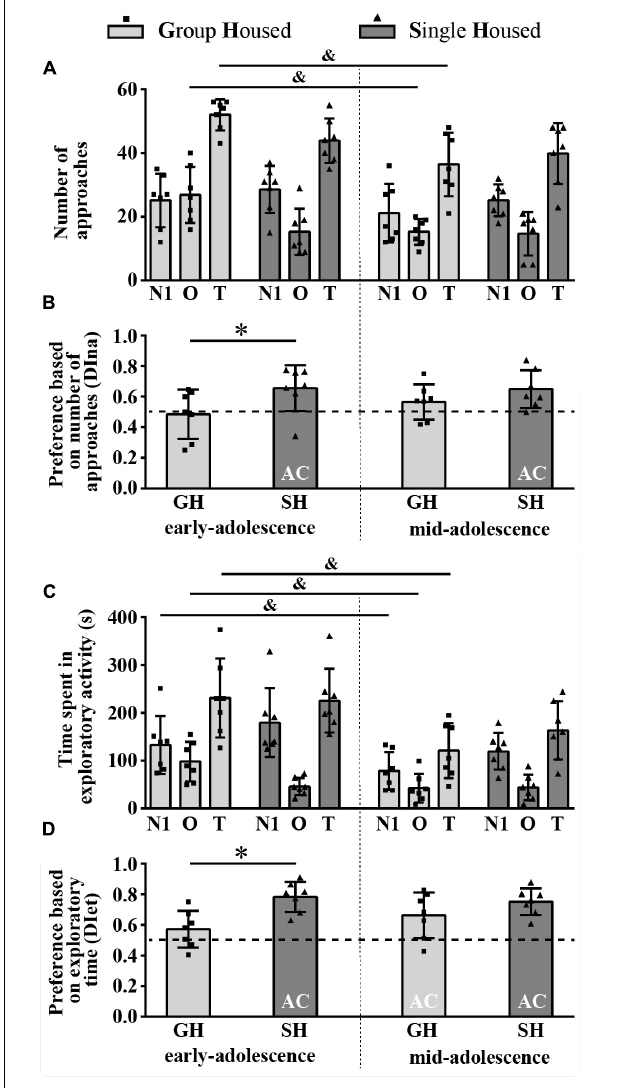
FIGURE 4 | The sociability of peripubertal male rats in the 3-chamber test at the end of the first week (early-adolescence) and the second week (mid-adolescence) of defined housing, which began on the 29th postnatal day. The data are represented as mean ± SD , with individual data plots along the column bars. (A) The number of approaches to the N1, the O, and the total number of approaches (T). (B) Discrimination index based on the number of approaches (DIna), addressing the “wanting” aspect of the preference for the N1 over the O, i.e., sociability. (C) Time spent in the exploration of the N1 and the O and total exploratory time. (D) Discrimination index based on exploratory time (DIet), addressing “liking” aspect of the preference for the N1 over the O, i.e., sociability. AC – significantly above the chance level (0.5); & p ≤ 0.05 (early-adolescence vs. mid-adolescence (maturation) within the same housing conditions); ∗ p ≤ 0.05 (single housed vs. group housed within the same maturational period). Statistical comparisons and exact p -values are given as Supplementary Table S1